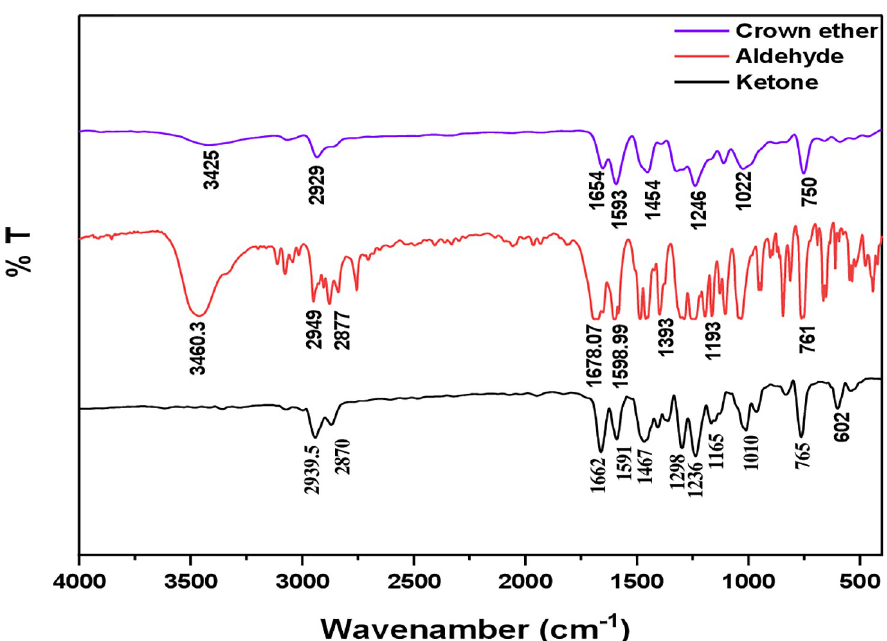
Fig 1. FT-IR spectrum of Crown ether, Aldehyde, and